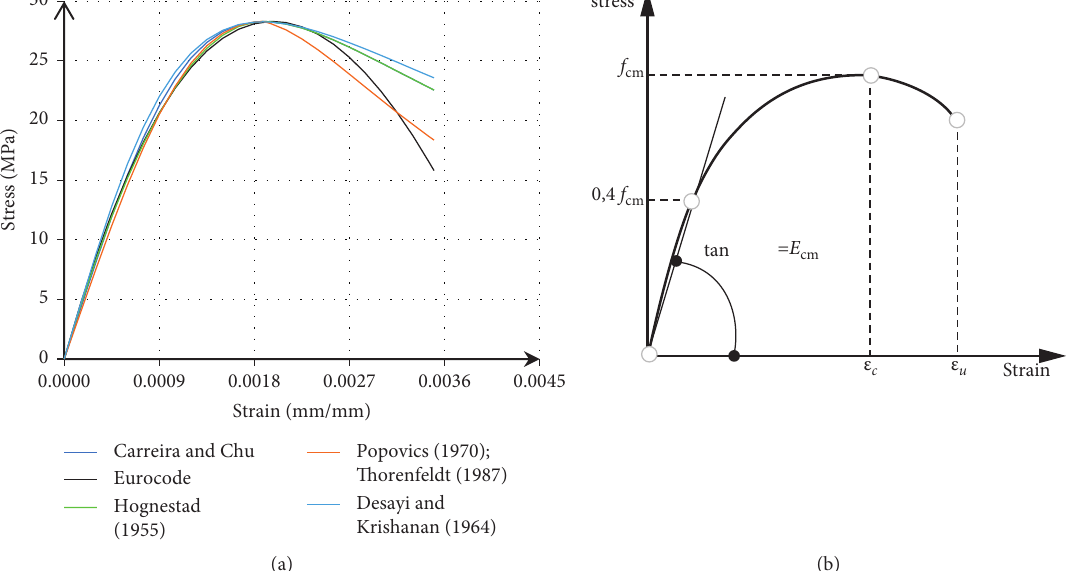
Figure 6: Concrete compressive stress-strain relation. (a) Common concrete models. (b) Eurocode based